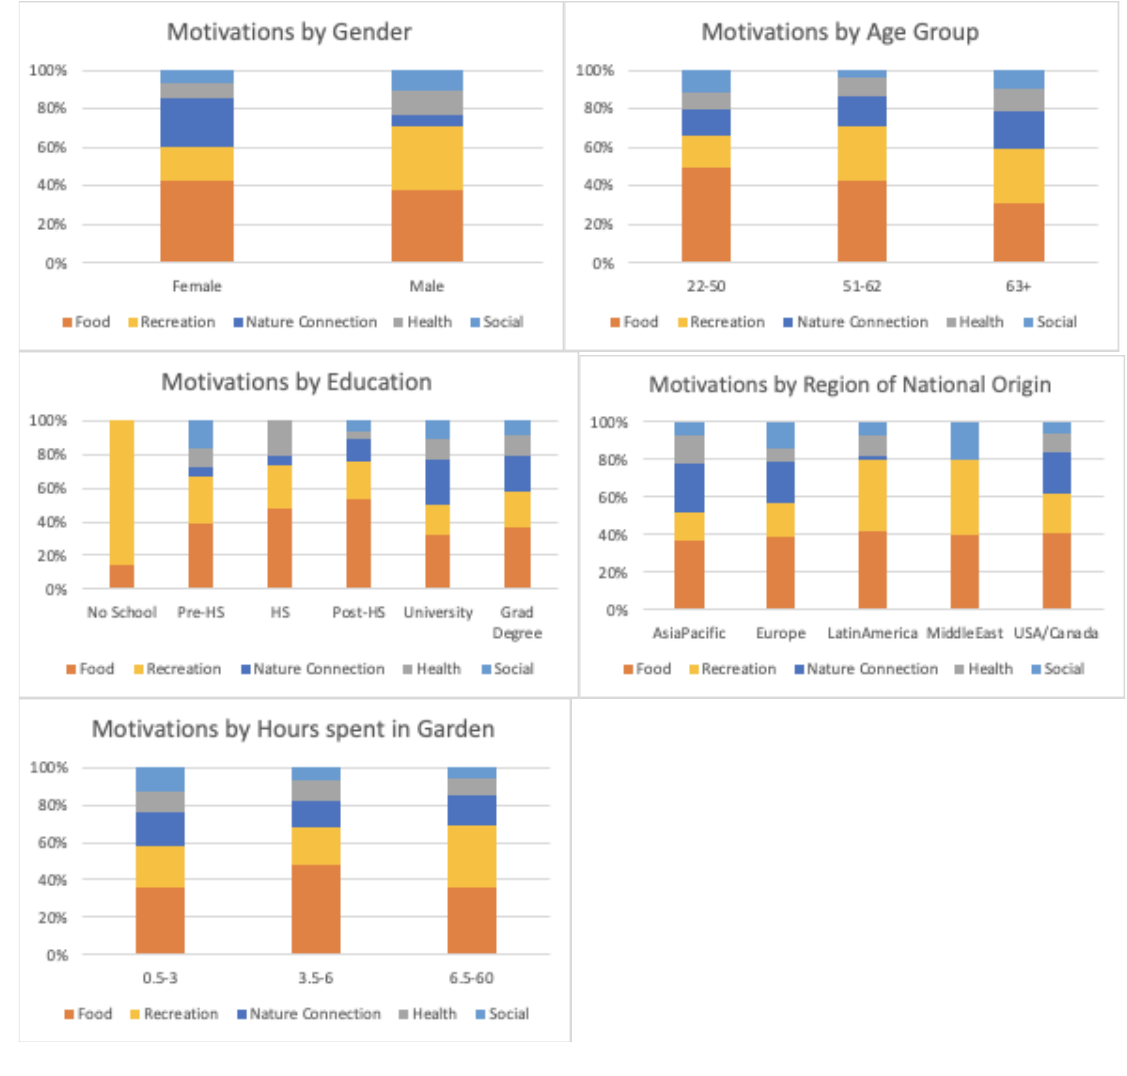
Figure A2.5. Relationships between motivations for gardening and gender, age, region of national origin, education, and hours spent